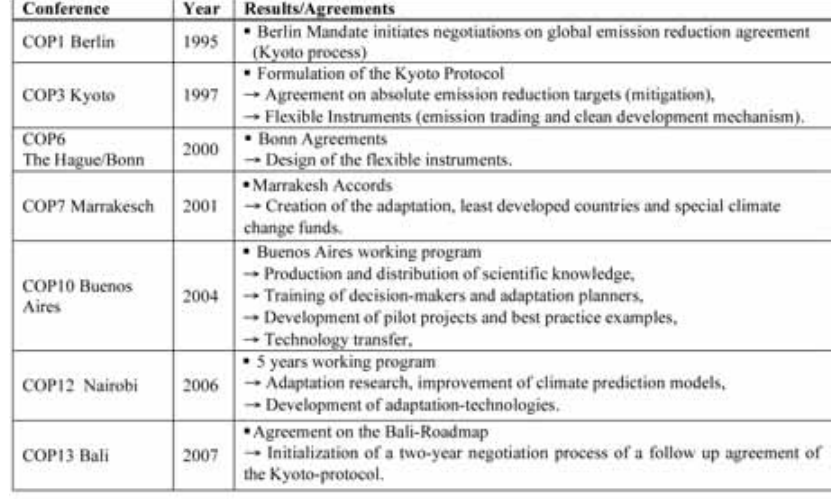
Table 1: Important steps in international climate